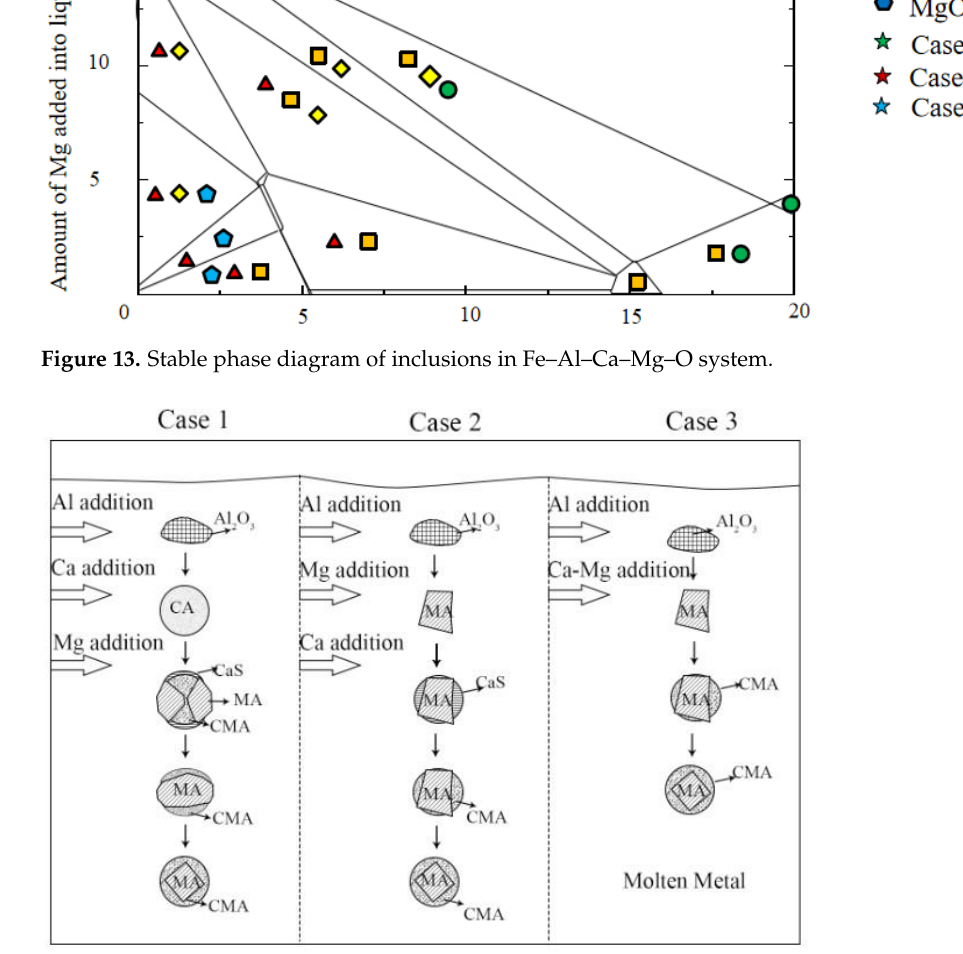
Figure 14. Evolution of inclusions in the three experiments.